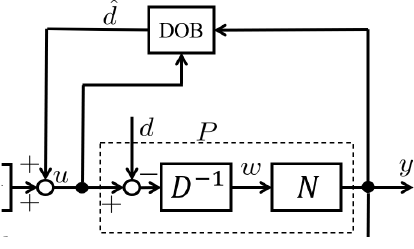
Figure 11. Disturbance